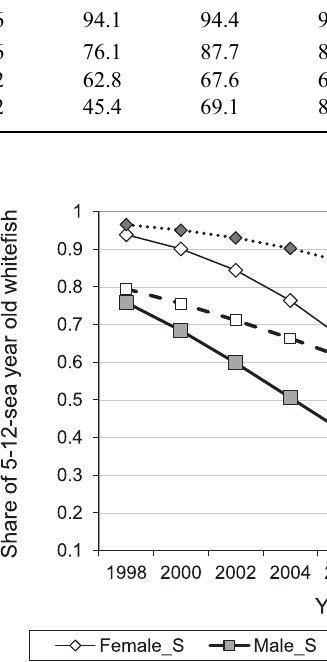
Fig. 2. The predicted share of 5 – 12-year-old mature female and male anadromous white fi sh ( Coregonus lavaretus ) in the catch in the northern (N) and southern (S) Gulf of Bothnia (GoB) in relation to the catch year (1998 – 2014). The response variable was classi fi ed as young (age 2 – 4) or older (age 5 – 12 years) fi sh. The age group, sex and area are predictors (model Tab. A.1). Sample sizes for young and old fi sh 4620 and 6345 in GoB,